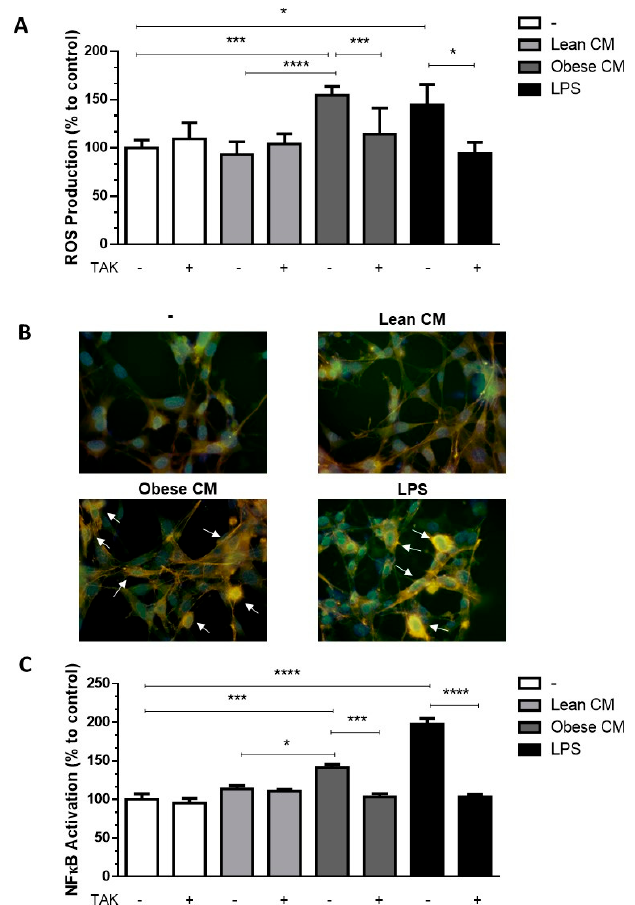
Figure 2. 3T3-L1 cells were left untreated or were pre-incubated with TAK-242 (TAK) 1 μ M for 15 min, at 37 ◦ C / 5% CO 2 . After pre-treatment, 3T3-L1 cells were treated or not with Lean Conditioned Medium (CM), Obese Conditioned Medium, or LPS 1 µ g / mL for 2 h. ( A ). Reactive oxygen species (ROS) production was assessed using CM-H 2 DCFDA probe. ( B ). NF- κ B translocation to nucleus was evaluated by immunofluorescence staining with anti-NF- κ B-FITC (green), actin was visualized using phalloidin-rodhamin (red) and nuclei was visualized using DAPI (blue). Arrows indicate the NF- κ B presence in nucleus. Results are representative of three different experiments. ( C ). NF- κ B activation was evaluated by luciferase activity. ( A , C ). Results are representative of three independent experiments. Data are expressed as means ± SEM. * Represents p < 0.05, ** represents p < 0.01, *** represents p < 0.005, **** represents p < 0.001.